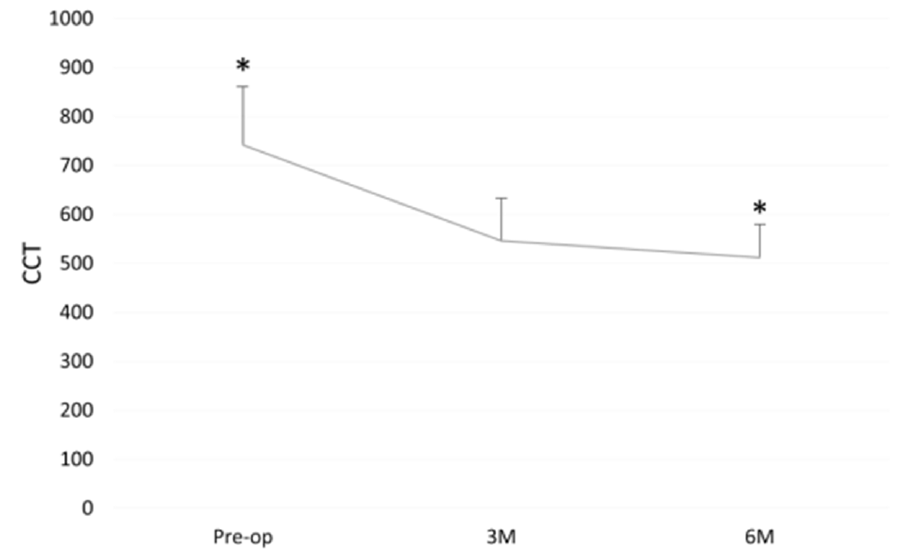
Figure 5. Central corneal thickness (CCT) before and after DMEK “Wave Maneuver” operation. Graph displaying the CCT before (Pre-op) and Post-op at 3 and 6 months after DMEK “Wave Maneuver” operation. CCT: central corneal thickness. M: months. Asterisk represents statistical significance ( p < 0.01) for Pre-op versus 6M. Donor endothelial cell density (ECD). The donor endothelial cell density (ECD) decreased (from a pre-operative DMEK “Wave maneuver” operation) in measurement count of 2878 ± 419 cells/mm 2 , to 1153 ± 466 cells/mm 2 at six months ( p < 0.01, Figure 6).